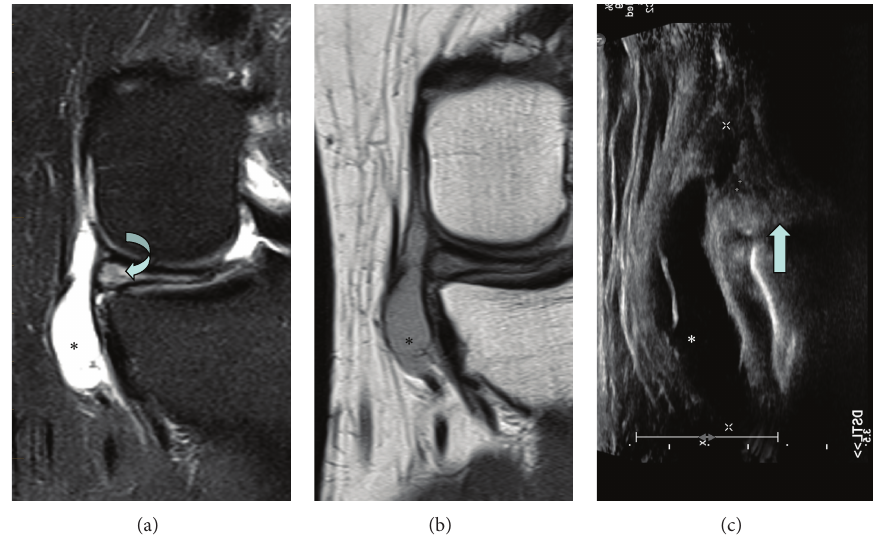
Figure 1: MRI and ultrasound demonstrate the meniscal cyst: (a) coronal fat-saturated proton density MRI. Curved arrow: intrameniscal tear, ∗ parameniscal cyst; (b) coronal proton density MRI. ∗ Parameniscal cyst; (c) ultrasound medial joint line. Straight arrow: horizontal cleavage plane tear medial meniscus, ∗ parameniscal cyst.